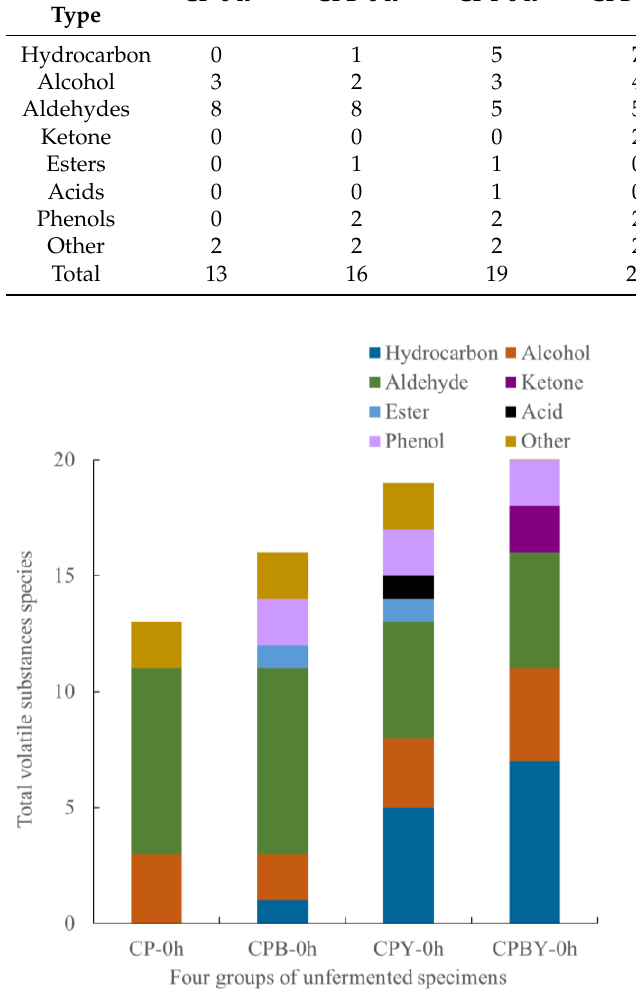
Figure 6. Comparison of volatile odor substances in four groups of unfermented specimens. CP-0 h, unfermented chickpea milk; CPB-0 h, unfermented chickpea milk with papain treatment; CPY-0 h, unfermented chickpea milk with yam addition; CPBY-0 h, unfermented chickpea milk with papain treatment plus yam addition.